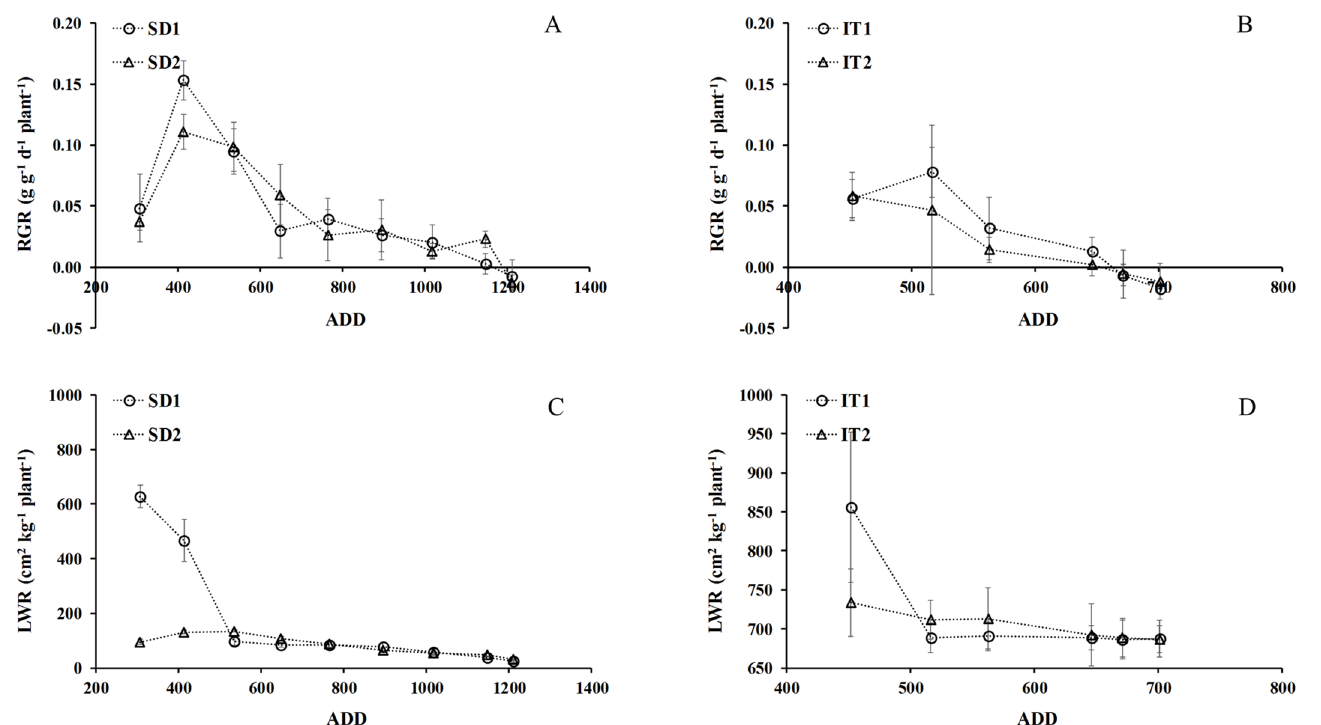
Fig 6. Relative growth rate (RGR) and leaf weight ratio (LWR) per plant as a function of accumulated day degrees (ADD). It shows both treatments from sowing to harvest for date of sowing (A, C) and water availability (B, D) in chia plants established in Antumapu and Intihuasi (x ± SD, n = 12).